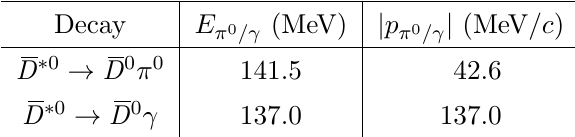
Table 3. D ∗ 0 breakup energy and momenta, resulting in the monochromatic π 0 or γ in χ c 1 (3872) → D 0 D ∗ 0